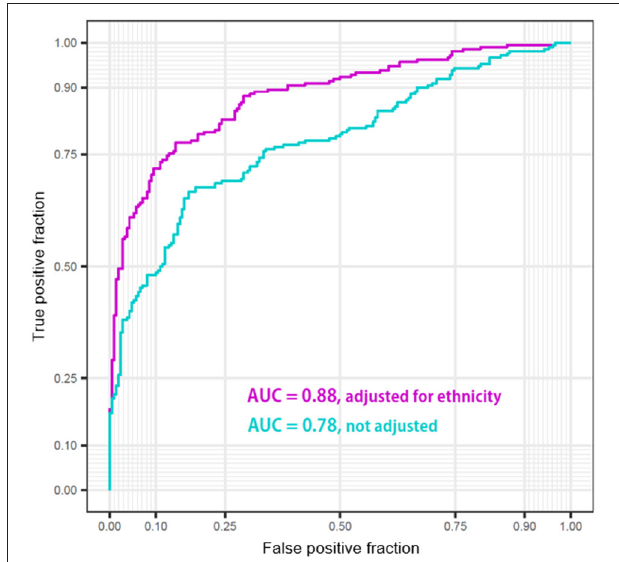
FIGURE 7 | Performance of the classifiers of Korean patients Alzheimer’s disease from Caucasian normal people using z-scores of bilateral temporal cortices, hippocampi, and amygdalae before/after adjustment for ethnic